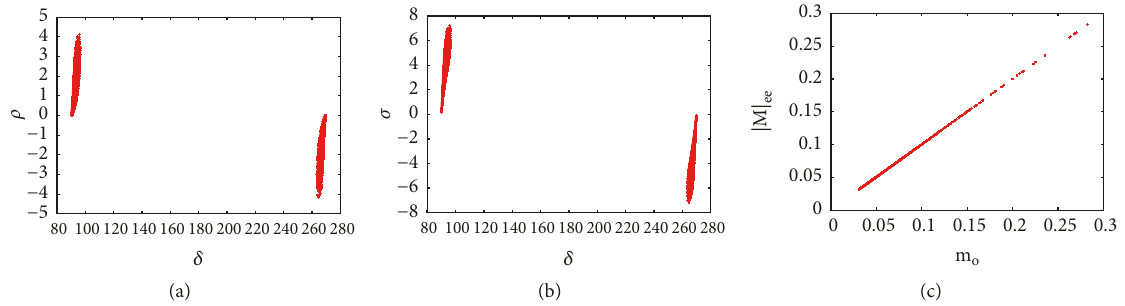
Figure 3: Correlation plots for texture 𝐵 2 (NS) for type X at 3 𝜎 CL. The symbols have their usual meaning. 𝛿, 𝜌 , and 𝜎 are measured in degrees, while |𝑀| 𝑒𝑒 and 𝑚 0 are in eV units.